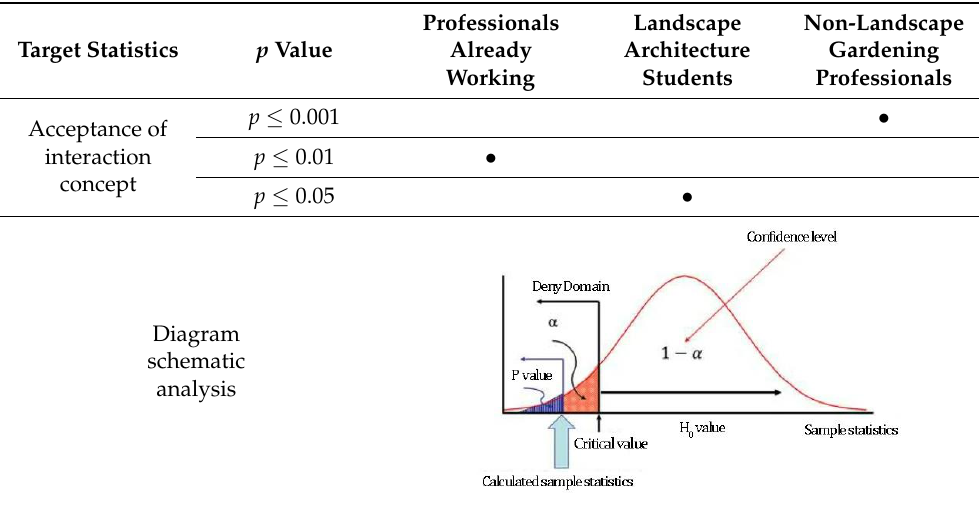
Table 5. Statistical differences in respondents’ willingness.